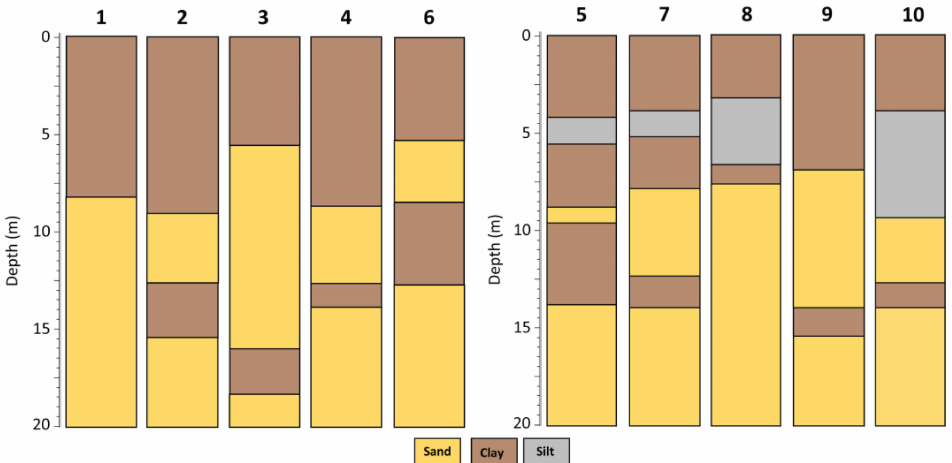
Figure 3. Ten borings were conducted along the periphery of the LSU School of Veterinary Science building in 1979 (courtesy of a private firm). We group the soil descriptions into three dominant sediment types: clay, silt, or